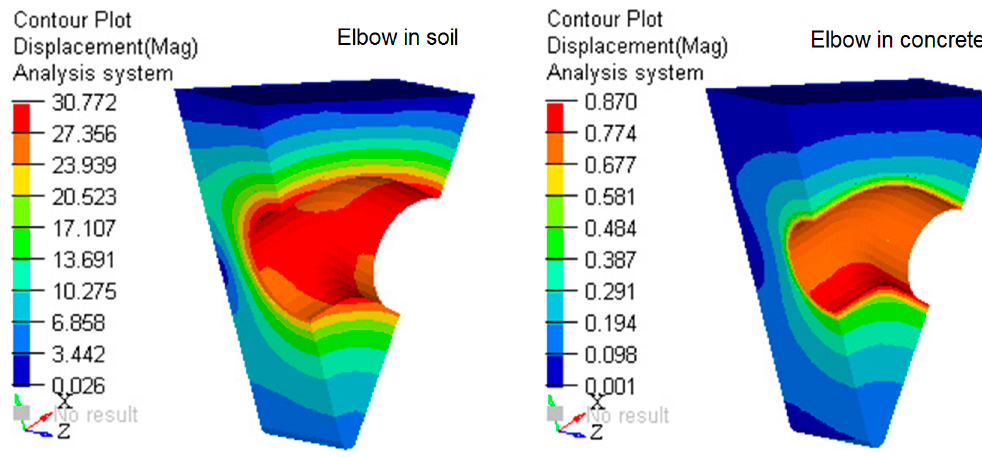
Appl. Sci. 2020 , 10 , x FOR PEER REVIEW Figure 19. Displacements in a section of massif, in mm (load pressure 50 MPa). Figure 19. Displacements in a section of massif, in mm (load pressure 50 MPa).